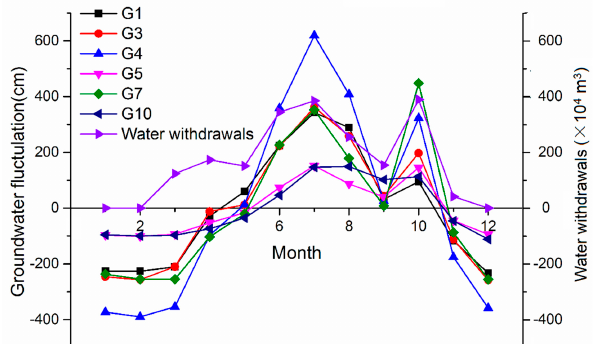
Figure 5. Seasonal subseries plot of the seasonal component estimated by the STL decomposition of depth of the piezometric groundwater level and the annual average groundwater withdrawals. Table 3. Groundwater well cases, mean yearly and monthly decline, seasonal peak/trough month and seasonal D-value, 2002–2014. Observation Mean Yearly Mean Monthly Seasonal Well Decline (cm) Decline (cm) Peak/Trough Month